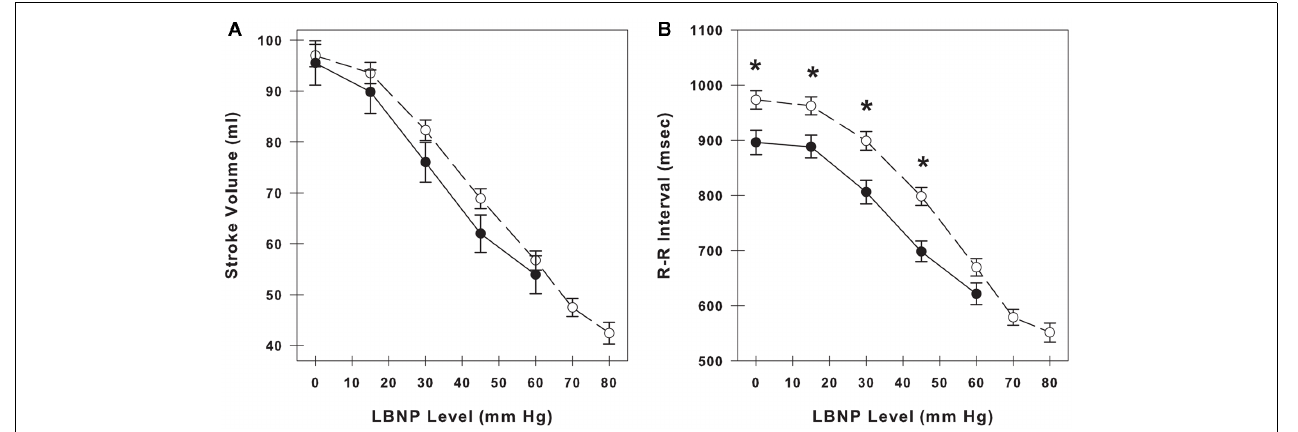
FIGURE 1 | Stroke volume (A) and R–R interval (B) during progressive lower body negative pressure (LBNP) in low tolerant subjects (closed circles, solid line) and high tolerant subjects (open circles, dashed line). At baseline, there are 33 low tolerant subjects and 87 high tolerant subjects.